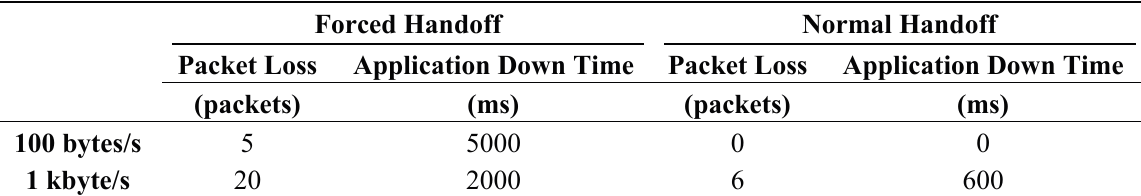
Figure 8. Experimental setup for evaluating the proposed handoff mechanism, with the sensor node roaming between different ADs. Table 1. Handoff mechanism evaluation results for normal and forced handoffs using different